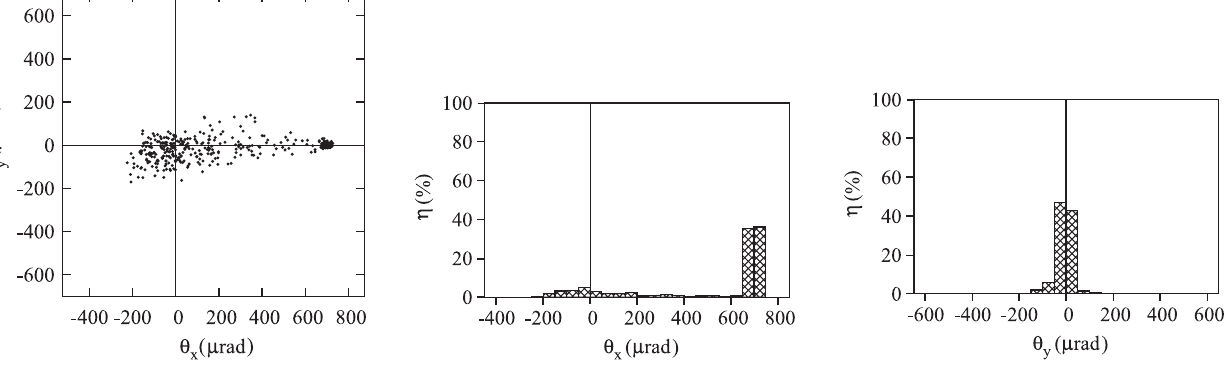
FIG. 12. The angular distribution (left), horizontal (middle), and vertical (right) profiles of the proton beam after passing through the bent crystal. Terms of entrance correspond to the motion of particles in the channeling regime in the vertical plane ð